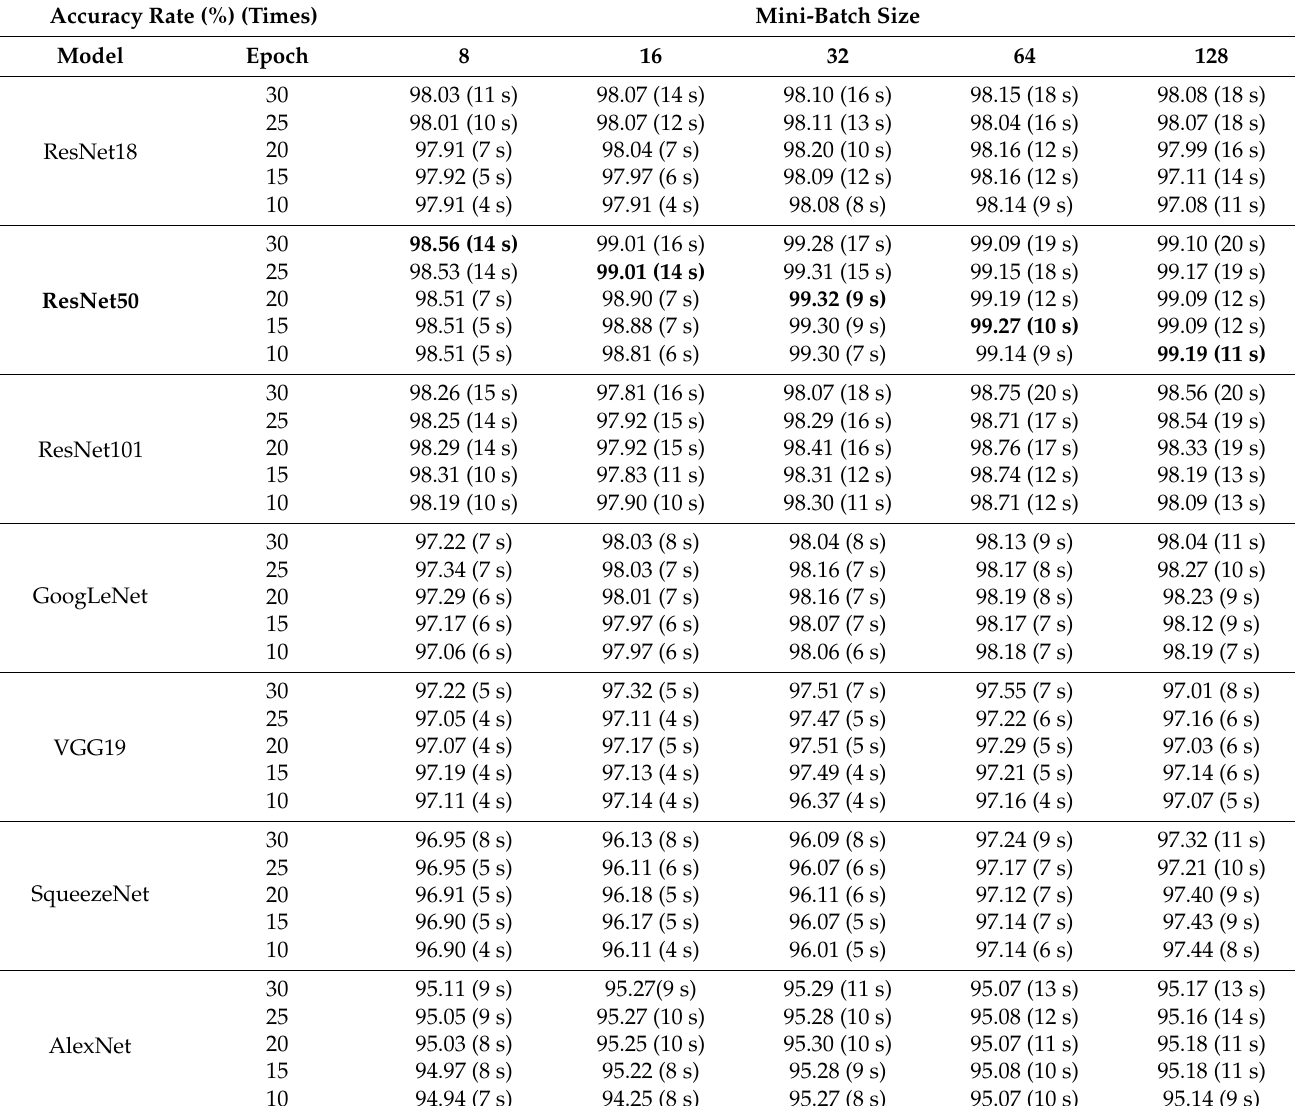
Table 8. Experiment II: the best result of nine tissue classes (CRC-VAL-HE-7K). Accuracy Rate (%)